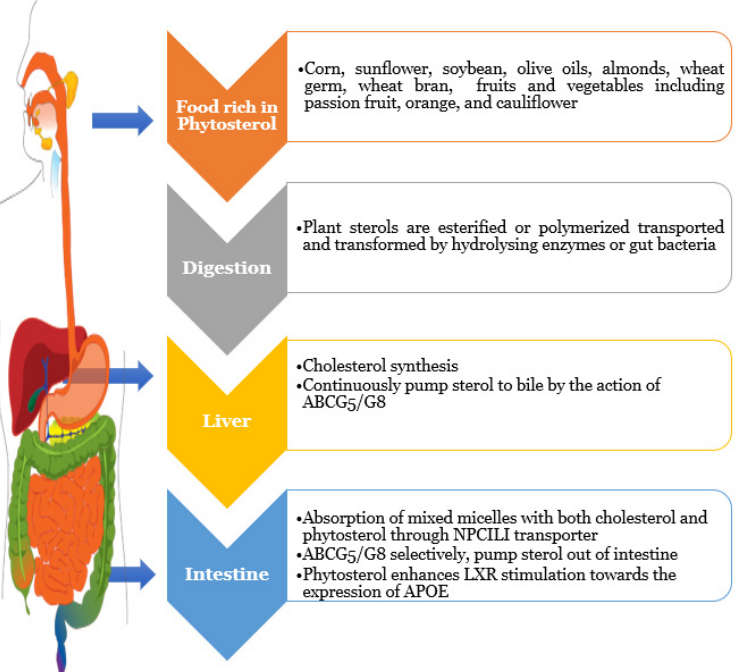
Figure 3. Phytosterols metabolism towards the regulation of cholesterol absorption. When phytosterol-rich foods are consumed, they are processed by liver enzymes that are comparable to those used to break down choletserol. It will reach the enterocytes after digestion, where phytosterol metabolism differs from cholesterol metabolism. Because these phytosterols are poor substrates of acyl-coA cholesterol actytransferase, they are not esterified and remain in the free form within the cell. Finally, the ATP-driven transporter heterodimer ABCG5/8 excretes the bulk of the free plant sterols back into the interstinal